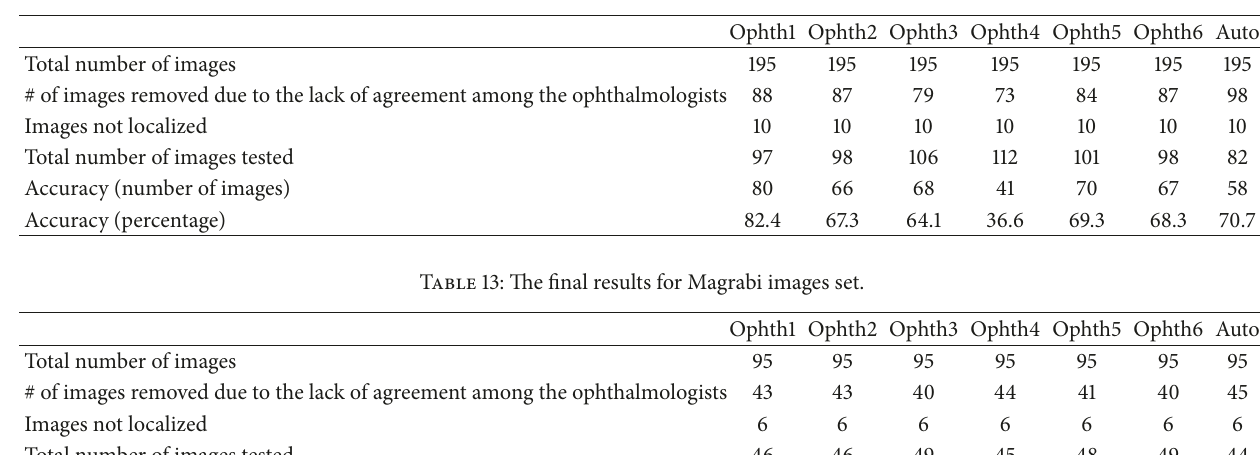
Table 12: The final results for Bin Rushed images set.